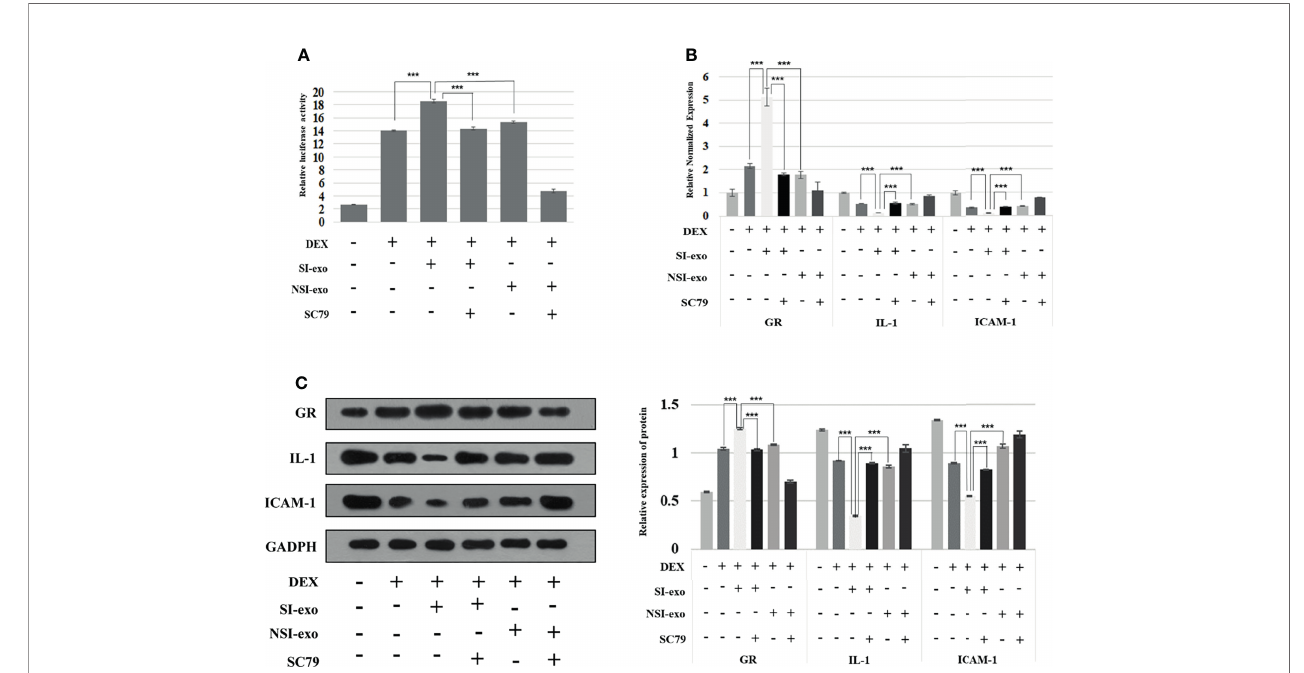
FIGURE 5 | SI-exo transfer miR-885-3p targeting AKT/NF k B improving the glucocorticoid sensitivity of OFs. (A) Plasmid activity of GRE luciferase reporter gene results in each group. DEX: 0.1 m m DEX-treated OFs for 24 h; SI-exo/NSI-exo: 25 m g/ml SI-exo/NSI-exo-treated OFs for 24 h; SC79: AKT agonist-treated OFs